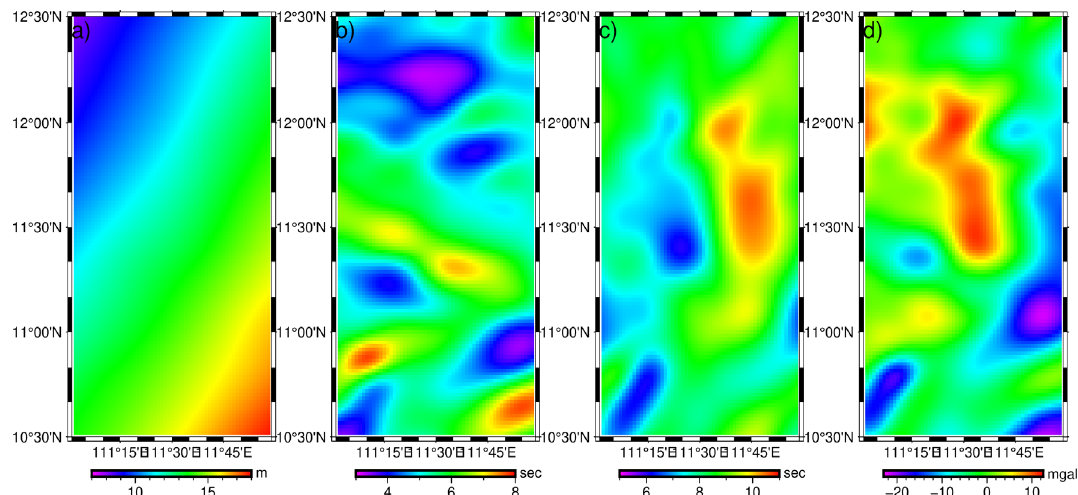
Figure 4. Simulated data (seen as true values): ( a ) SSH; ( b ) North-south component of DV; ( c ) East-west component of DV; ( d ) GA.